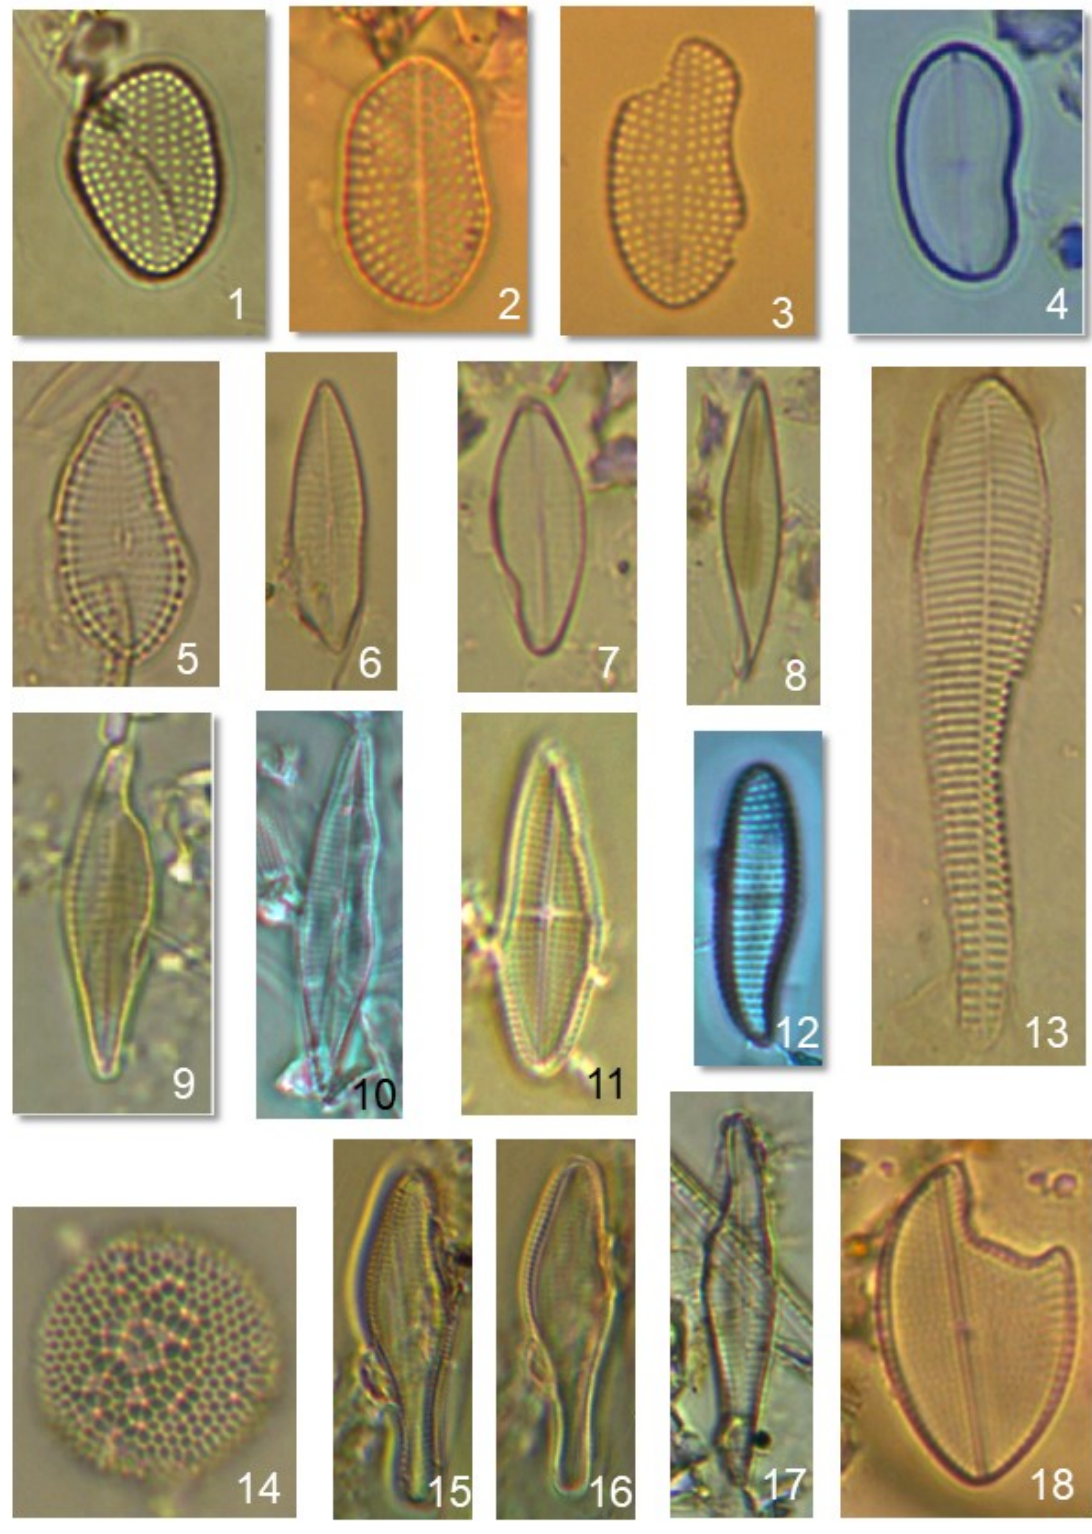
Figure 5. Deformed benthic diatom valves and areolae. (1)–(4) Cocconeis sp., (5) Cocconeis sp. (2), (6)–(8) Navicula sp., (9) –(12) Achnanthes sp. (13) Licmophora gracilis (Costa, SR), (14) Thalassiosira sp. (15)–(17) Achnanthes sp. (2), (18) Cocconeis sp. (sediment, CS). SR = Santa Rosalia, CS = control site.